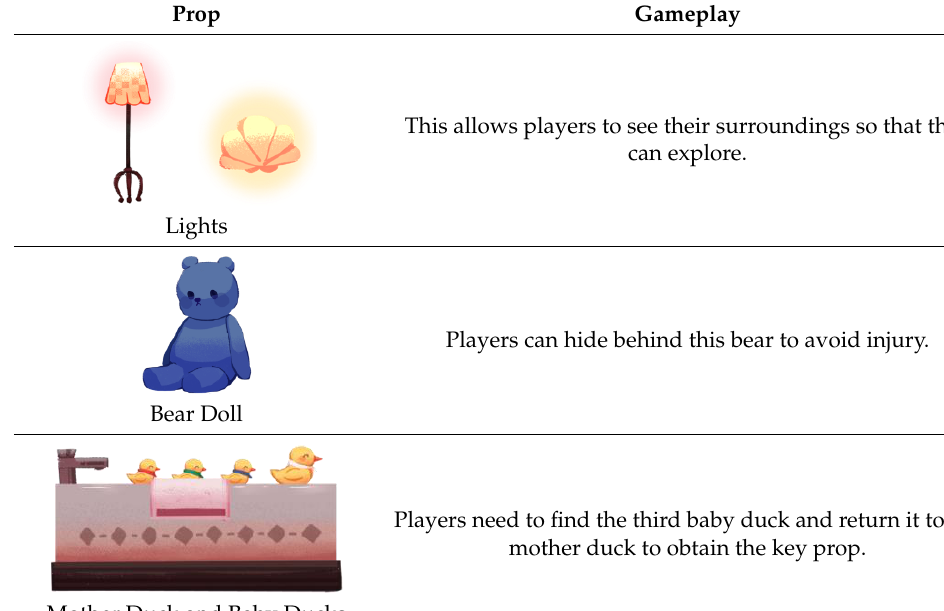
Table 9. Mean and standard deviation of experimental data.